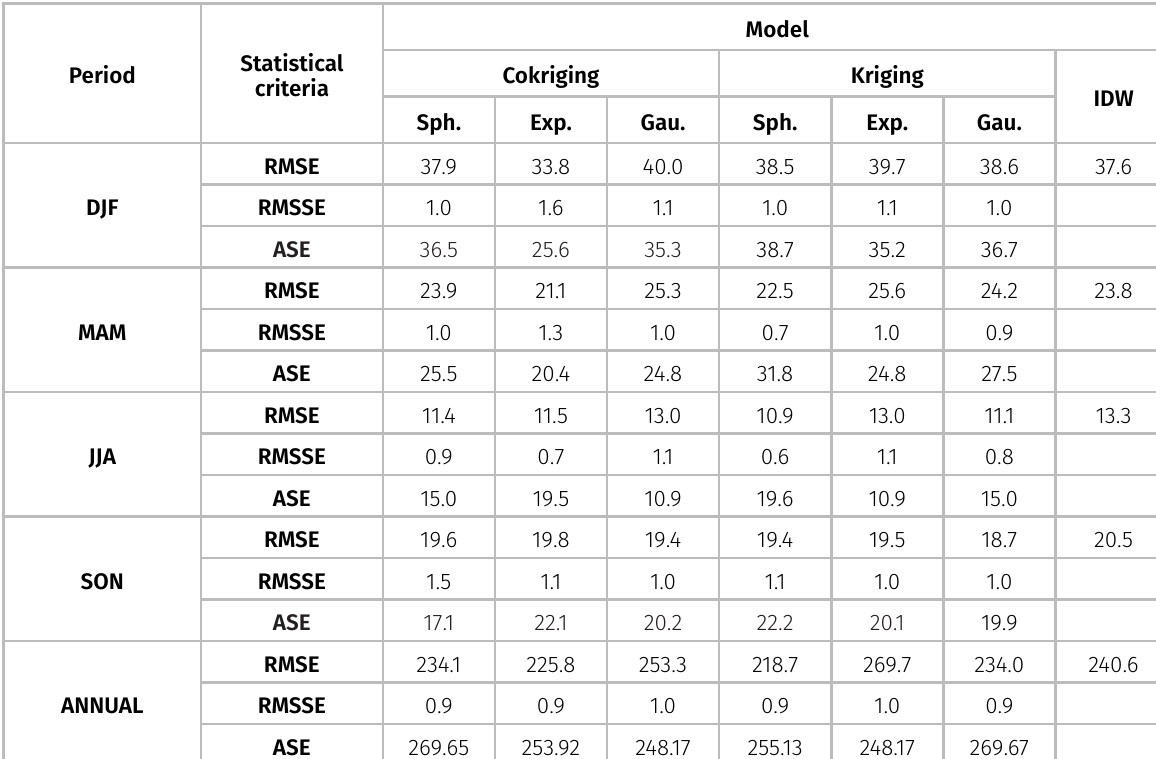
Table III. Cross-validation comparison for the LPB interpolation models.